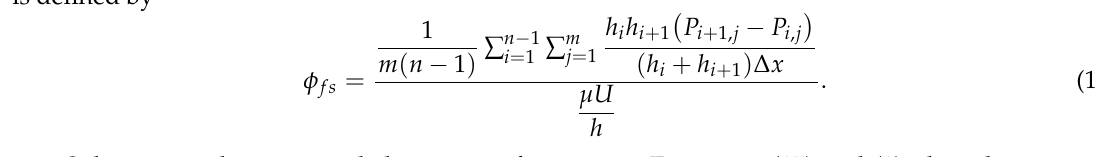
Figure 10. Minimum oil film thickness and friction force predicted based on improved model 1 considering dynamic deformation.